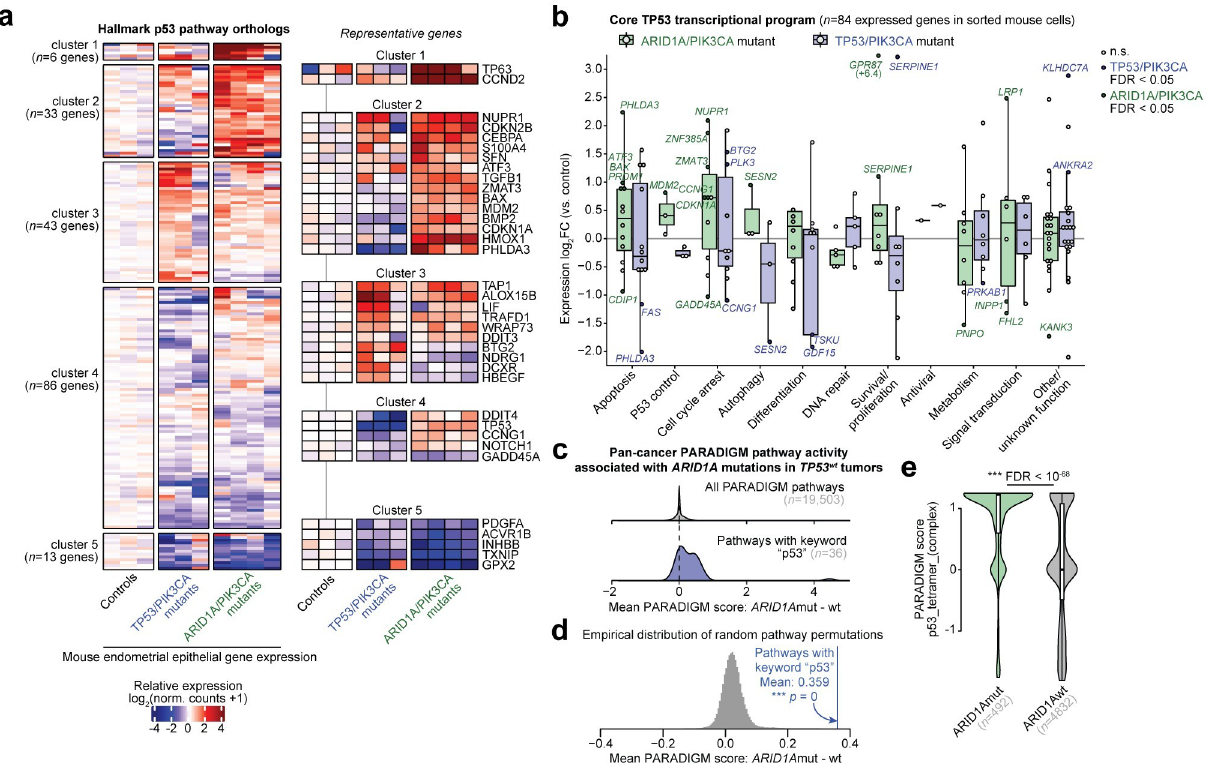
Fig 5. ARID1A mutation is associated with p53 pathway activation. a , k -means clustering and heatmap of genetic mouse model RNA-seq relative log 2 gene expression data for MSigDB Hallmark p53 pathway genes ( n = 181 expressed orthologs). Representative genes are highlighted on the right. b , Differential expression of core TP53 transcriptional program gene orthologs, segregated by function, in mouse endometrial epithelial cells from ARID1A/PIK3CA mutants (green) and TP53/PIK3CA mutants (blue) compared to controls. Significant DE genes (FDR < 0.05) in each model are labeled and respectively colored. c , Distribution of PARADIGM score differences between ARID1A mutant ( n = 492) vs. wild-type ( n = 4832) TCGA Pan-Cancer Atlas tumors, considerate of only TP53 wild-type tumors. Top, all 19,503 measured pathways; bottom, the 36 pathways with keyword “p53”. d , Empirical distribution of mean differences between ARID1A mutant vs. wild-type PARADIGM scores, based on 50,000 samples of 36 random PARADIGM pathways. The blue line represents the mean score difference for the 36 pathways with keyword “p53” with associated permutation statistic. e , Example violin plot for the top p53 PARADIGM pathway significantly different between ARID1A mutant vs. wild-type tumors. Statistic is FDR- adjusted, two-tailed, unpaired Wilcoxon test.